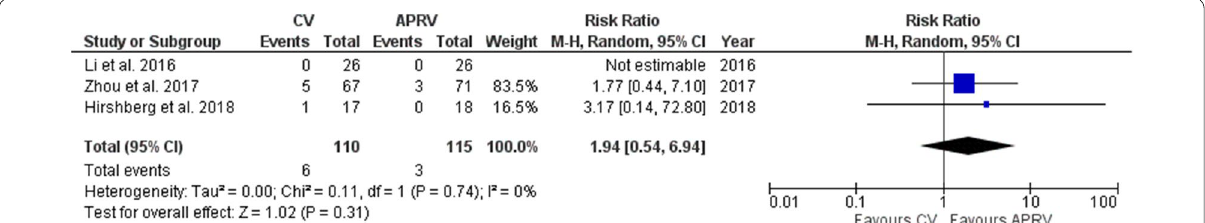
Fig. 7 Barotrauma. APRV airway pressure release ventilation, CV conventional